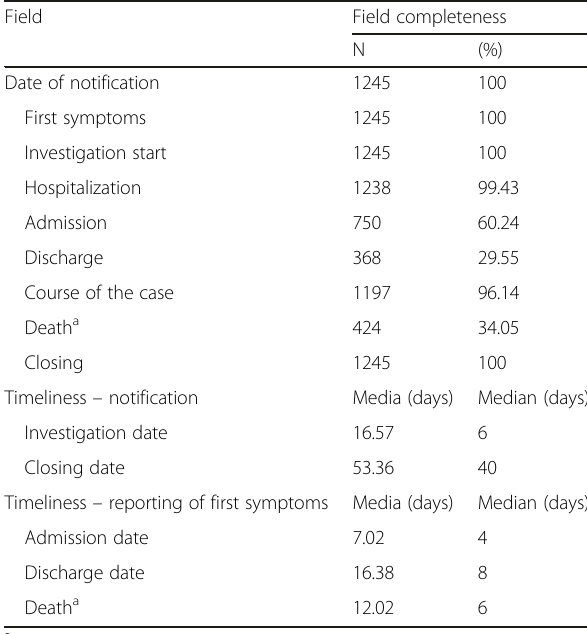
Table 2 Completeness of notification forms for spotted fever in Brazil (2007 – 2015) concerning dates of notification of the main variables, timeliness of notification and reporting of the first